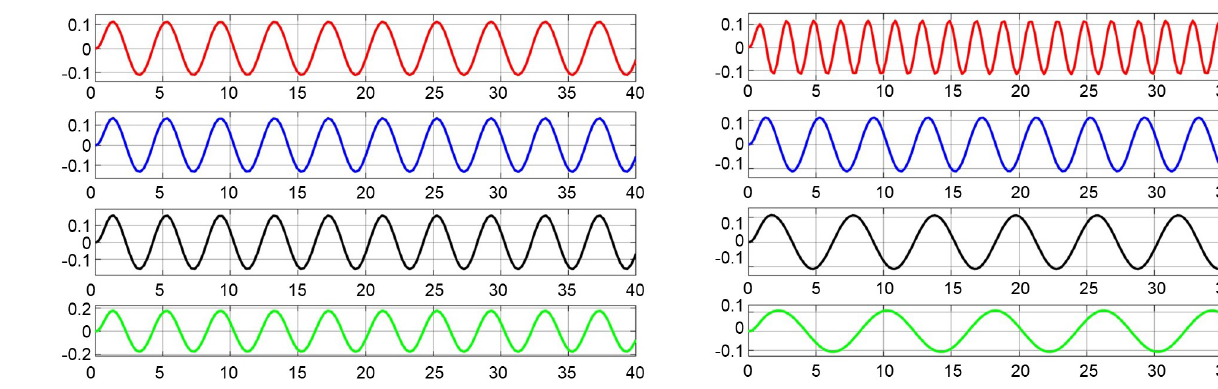
Figure 15. Movement law of the buoy at different wave heights. (The wave heights from top to bottom are 1, 1.2, 1.4 and 1.8m.)